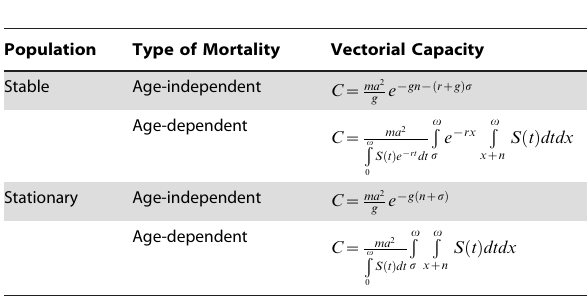
Table 2. Formulas for vectorial capacity in stable and stationary vector